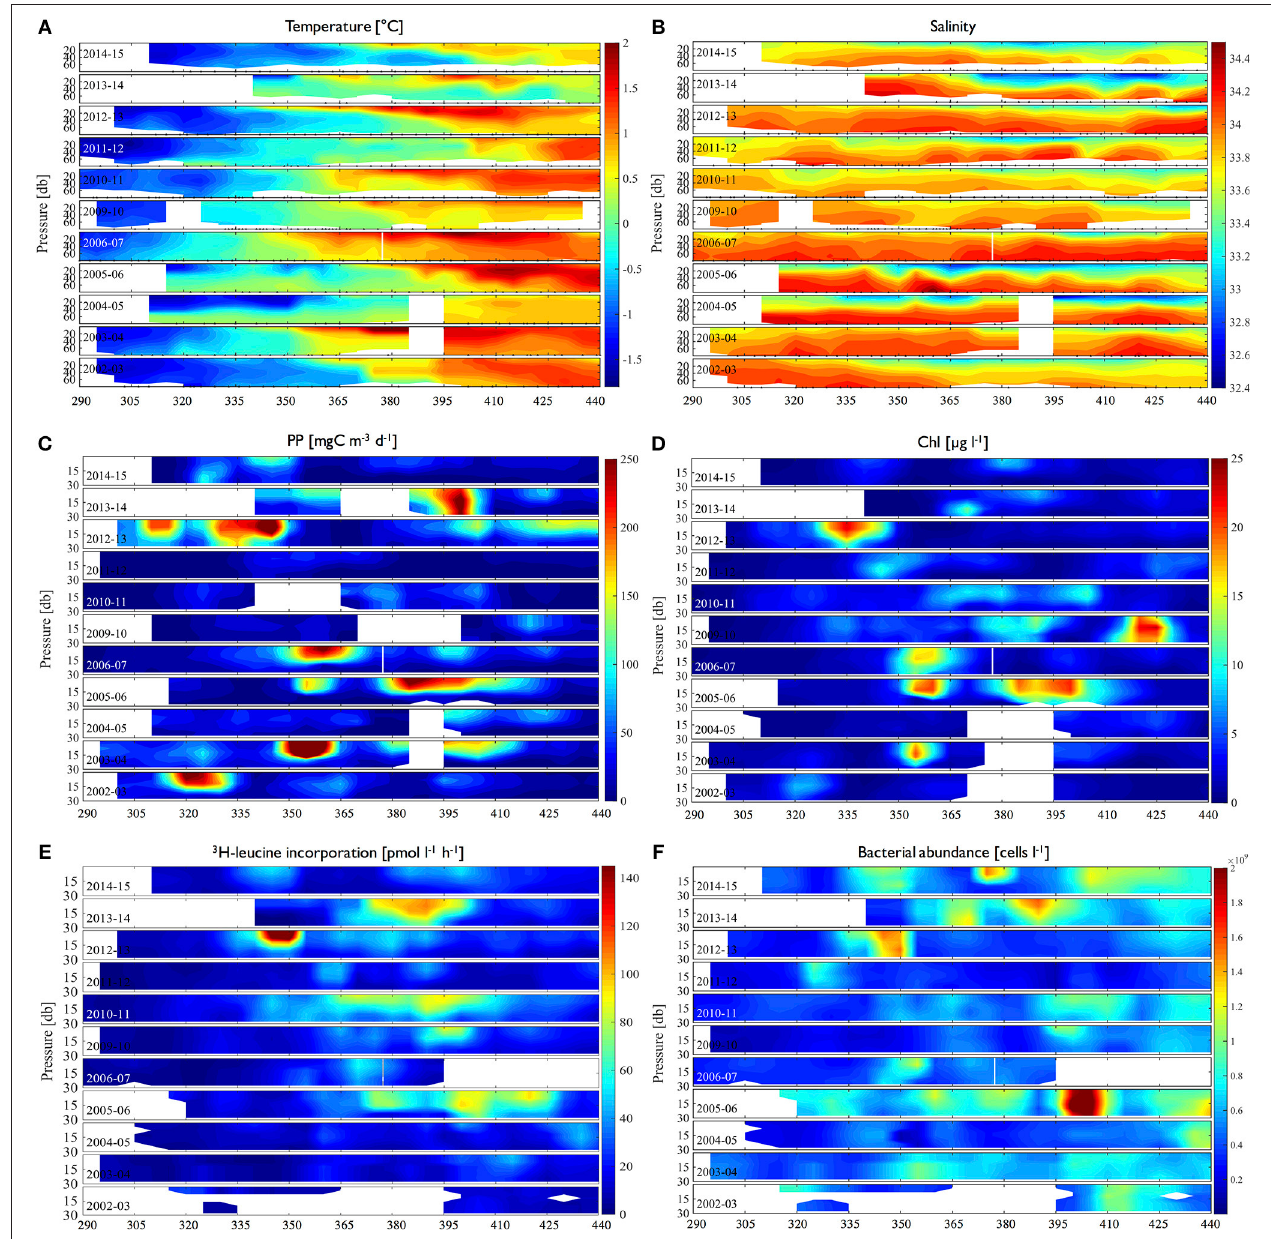
FIGURE 2 | Time-depth distributions of physical properties (A. temperature, B. salinity), volumetric phytoplankton (C. PP, D. Chl) and bacterial properties (E. 3 H-leucine incorporation rates, F. bacterial abundance) for individual years (2002–2003 to 2014–2015) over full growing seasons (day of year 290 to 440 or mid-October through March. Black triangle marks on the x-axis indicate sampling time